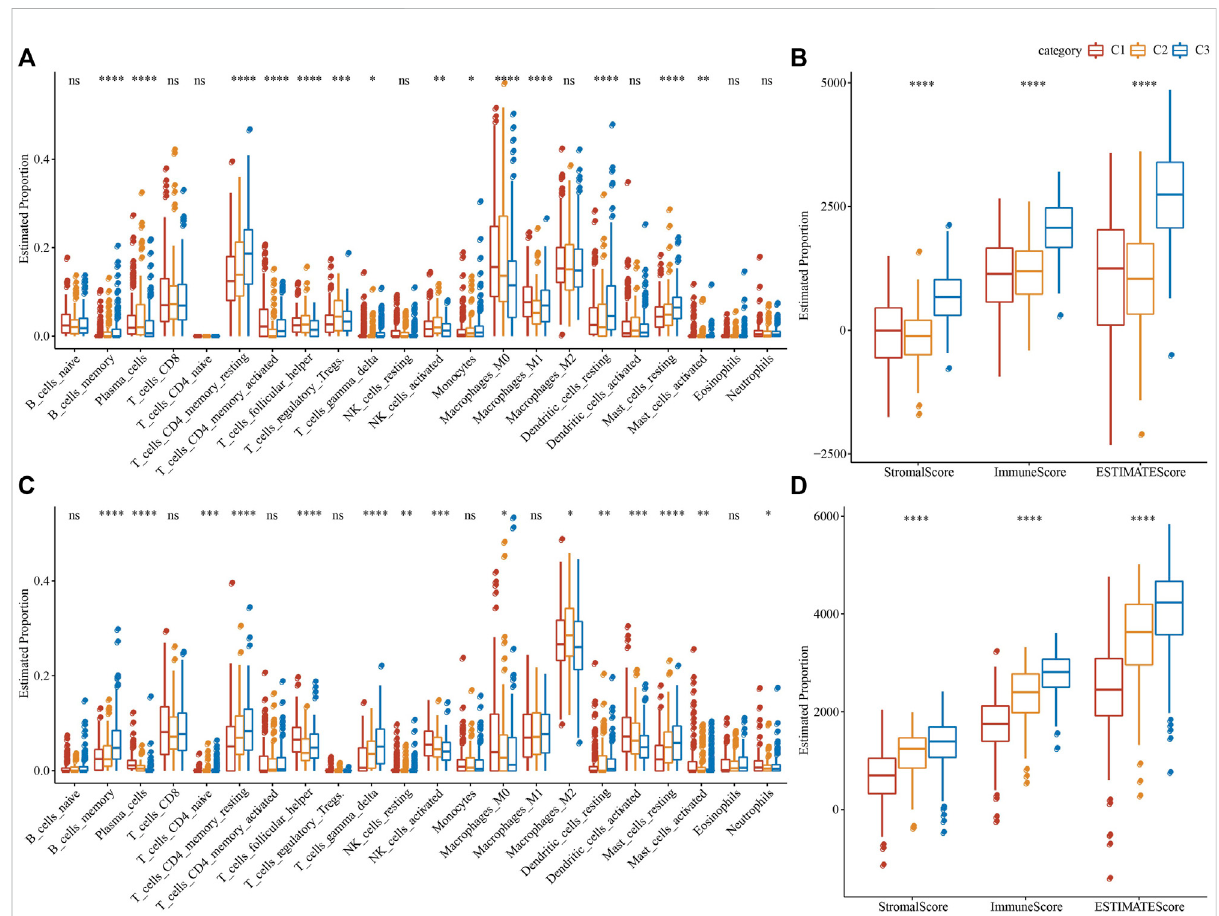
FIGURE 4 ProportionofimmunecellcomponentsintwoLUADcohorts. (A) Thevariationof22immunecellscoresamongdifferentmolecularsubtypesin the TCGA cohort; (B) The difference of ESTIMATE immune in fi ltration among different molecular subtypes in the TCGA cohort; (C) Differences in scores of 22 immune cells in various molecular subtypes in GSE72094 cohort; (D) Differences of ESTIMATE immune in fi ltration in various molecular subtypes in GSE72094 cohort. * p < 0.05, ** p < 0.01, *** p < 0.001, and **** p <